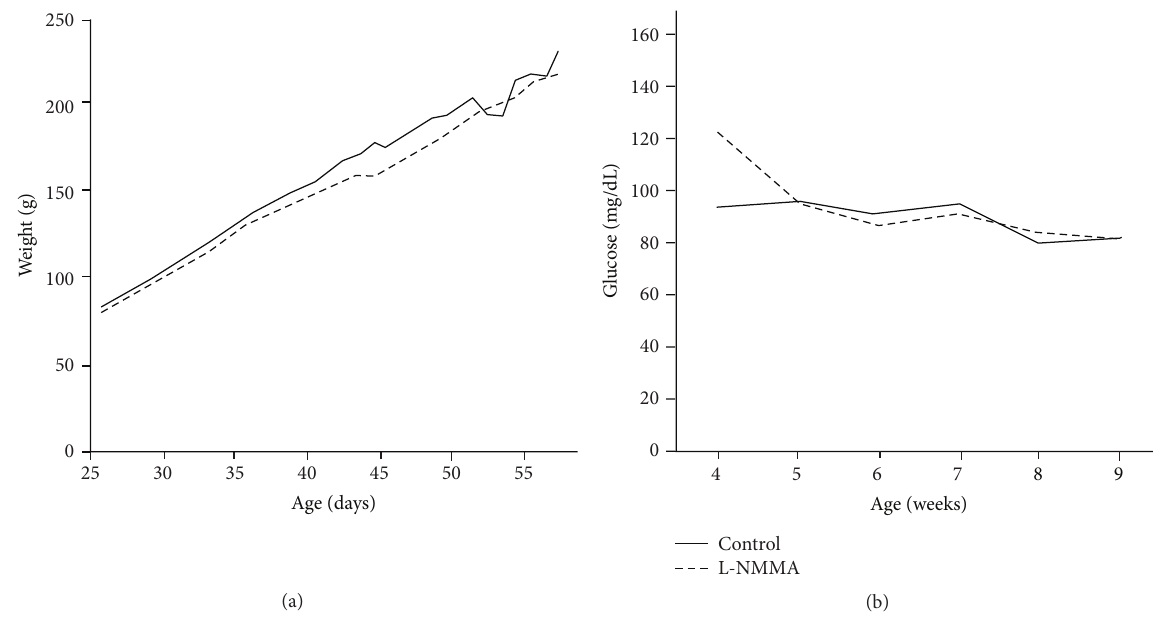
Figure 5: (a) Body weights were daily recorded in untreated (solid line) and L-NMMA-treated (dotted line) BB rats between 4 and 9 weeks of age. (b) Random blood glucose levels were weekly determined in untreated (solid line) and L-NMMA-treated (dotted line) BB rats